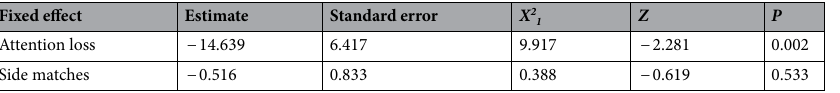
Table 1. Effects of two variables on test performance (correct choice: 1 or incorrect choice: 0) using a generalised linear model with a binomial distribution and logit link function. Attention loss is the proportion of the duration of attention loss during the total duration of the test trial. Side matches are the value of whether the side of the choice between the last trial in the pre-test and the test trial matched (same sides: 1 or different sides: 0). For the details, refer to the “Materials and methods”